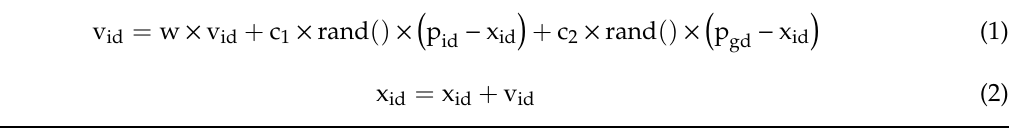
Algorithm 1 Pseudo Code for PSO